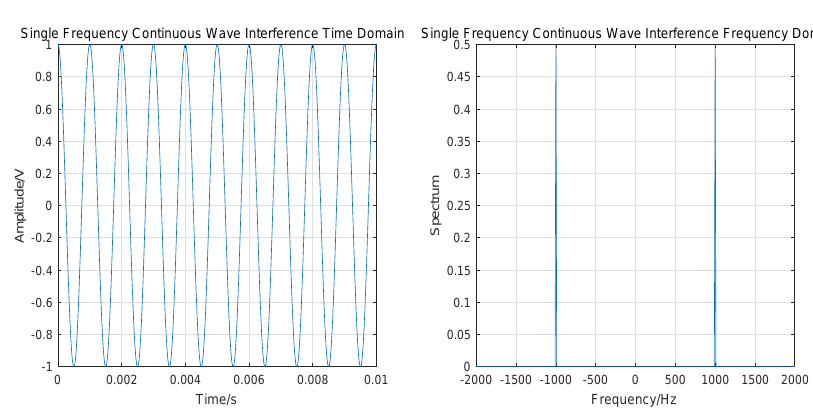
Figure 10. SFCW interference time–frequency domain simulation.